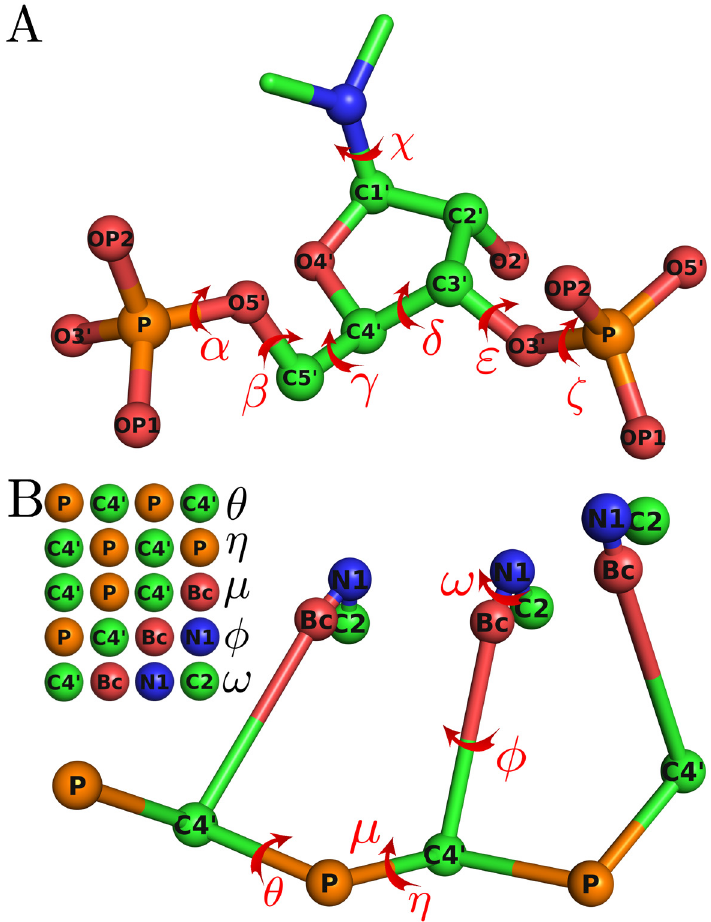
Fig 1. Schematic representation of all-atom and CG model for RNA. (A) Seven torsional angles of an RNA molecule. (B) Five torsional angles defined in the coarse-grained model in this work. The relevant four beads for each torsional angle are shown on the top